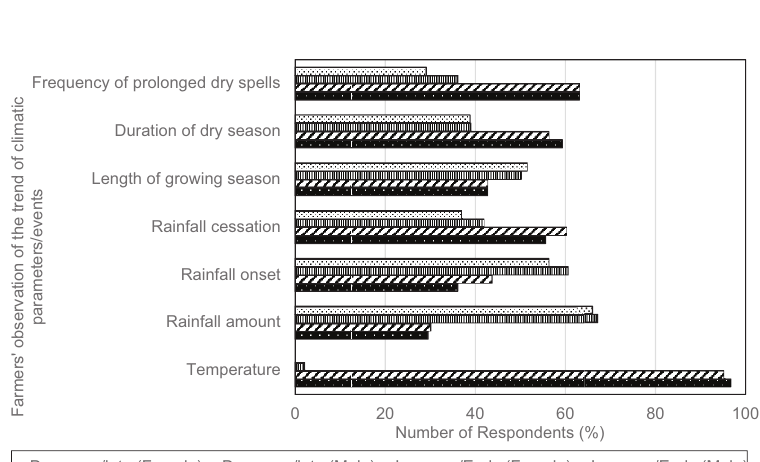
Figure 3. Farmers ’ observed